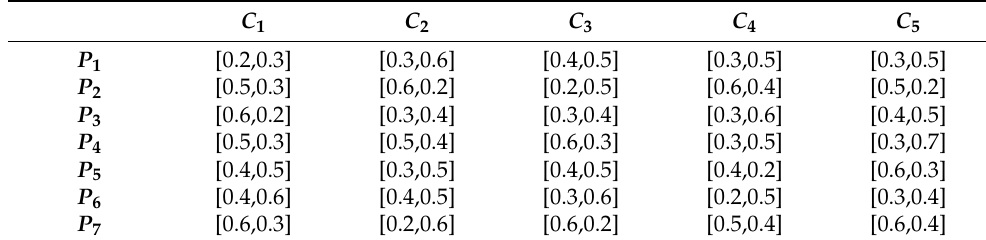
Table 4. Original evaluation criteria information matrix at the moment t 3